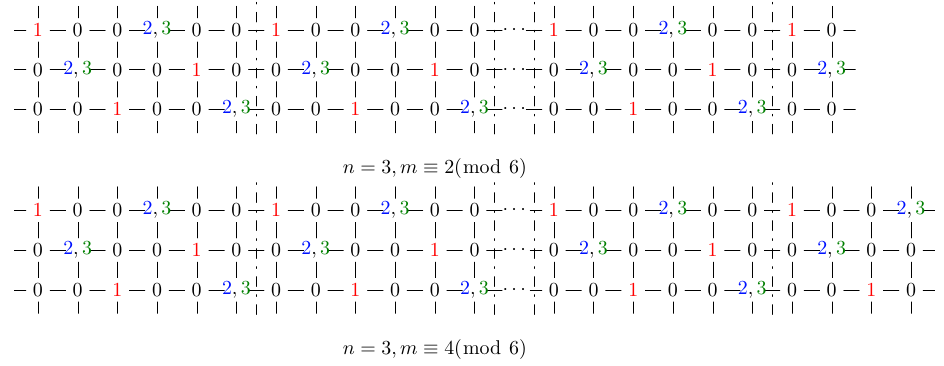
2,4 ( mod 6 ) 2,4 ( mod 6 ) ≡ ≡